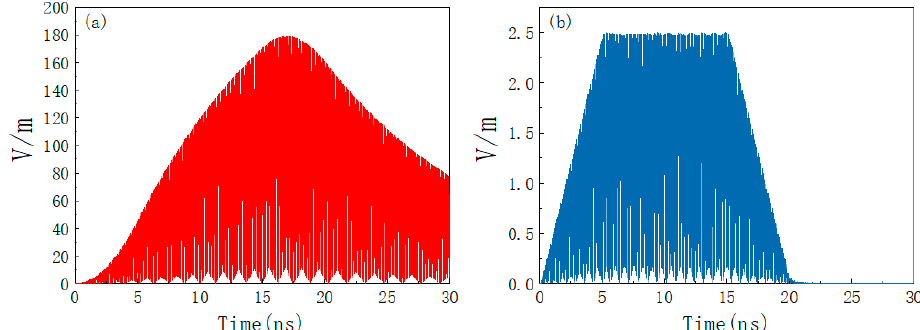
Figure 9. Electric field strength at the center of the product cavity under HPM amplitude illumina- tion. ( a ) No absorbing material; ( b ) placement of absorbing material.